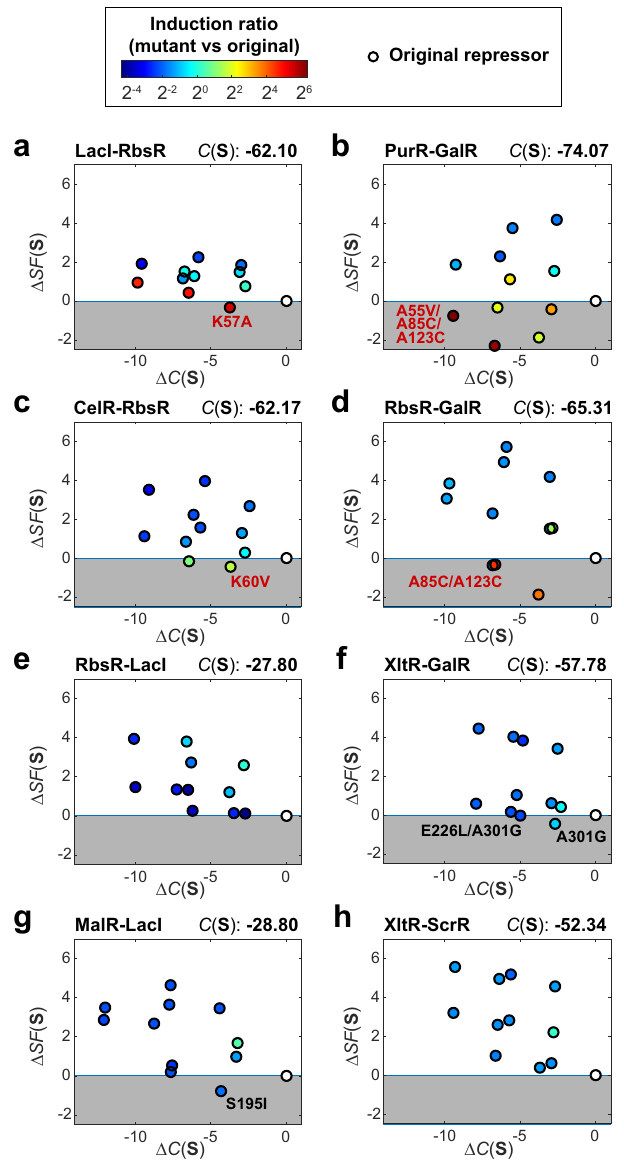
Fig. 3 Prediction from the SF (S) score model on structural feasibility of mutations for enhancing hybrid repressor activities. The structure-based scores, SF ( S ) are plotted against the compatibility scores, C ( S ) from experimentally tested mutant candidates of each hybrid repressors, including ( a ) LacI-RbsR ( b ) PurR-GalR, ( c ) CelR-RbsR,( d ) RbsR-GalR, ( e ) RbsR-LacI, ( f ) XltR-GalR, ( g ) MalR-LacI and ( h ) XltR-ScrR. In these plots, mutants in the gray region have a more favorable SF ( S ) score compared to their original repressor. Colorbar indicates the ratio of GFP fl uorescence induction for each mutant relative to the original repressor hybrid (marker fi lled with white), with red and blue to represent the increase and decrease of GFP fl uorescence, respectively. For repressors with improved mutants (fold-change of the mutant is >10 and >3 times of the original hybrid repressor), the mutant with the largest dynamic range of induction is labeled in red. For repressors without improved mutants, the mutants are labeled in black if their SF ( S ) score is more favorable than their original repressor, which represents exceptional cases that do not follow our model prediction. Source data are provided as a Source Data fi